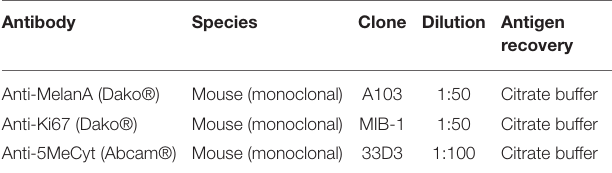
TABLE 1 | Primary antibodies used for immunohistochemistry and their dilutions.